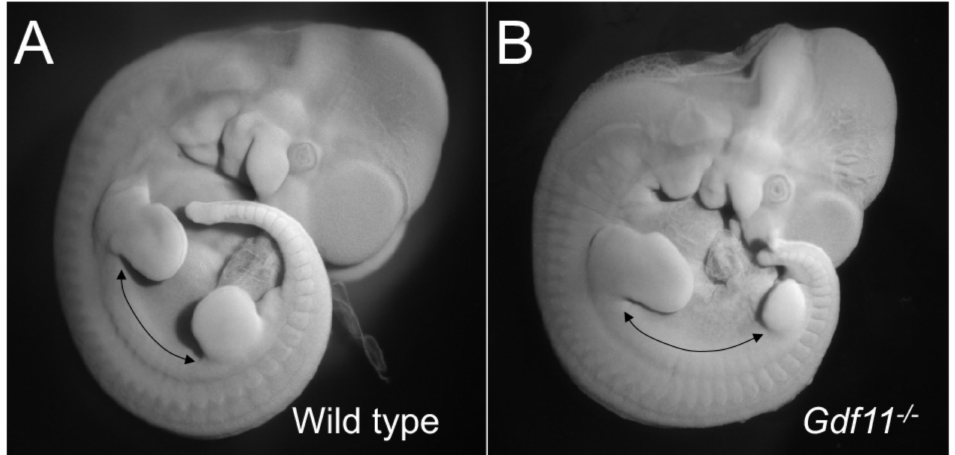
Figure 2. Trunk elongation in the absence of Gdf11 signaling. The figure shows a mouse wild type ( A ) and a Gdf11 -/- embryo ( B ) at embryonic stage 11.5, to illustrate the increase in size of the interlimb region (as estimated by the number of somites), which represents the trunk region, in Gdf11 mutant